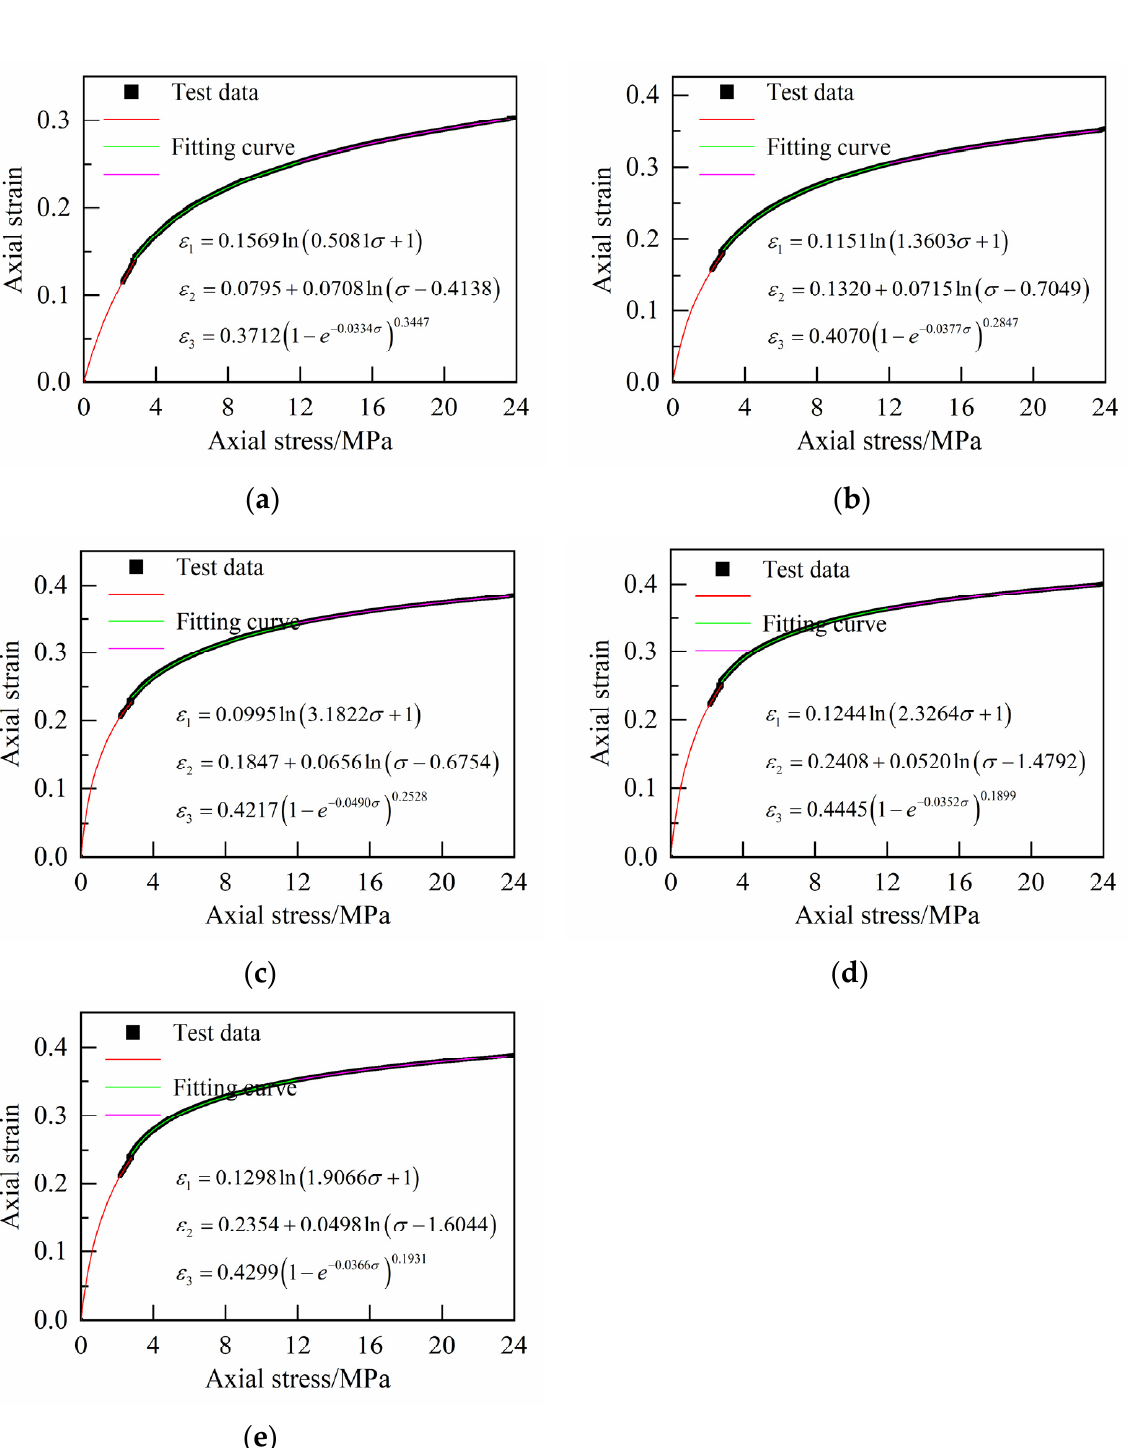
Figure 6. Strain–stress fitting curves under different water content conditions. ( a ) ω = 0%; ( b ) ω = 1.5%; ( c ) ω = 3.0%; ( d ) ω = 4.5%; ( e ) ω =